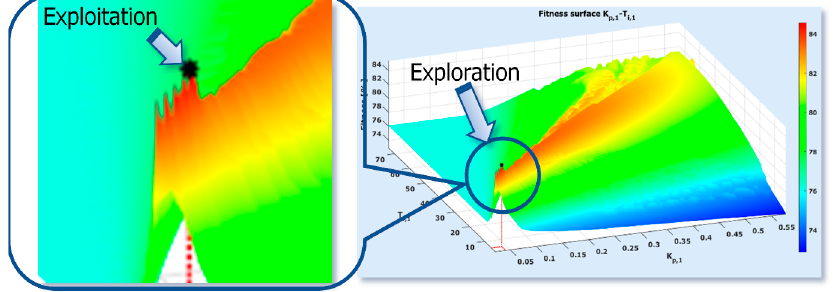
Figure 8. Exploration–exploitation strategy in fitness maximization.